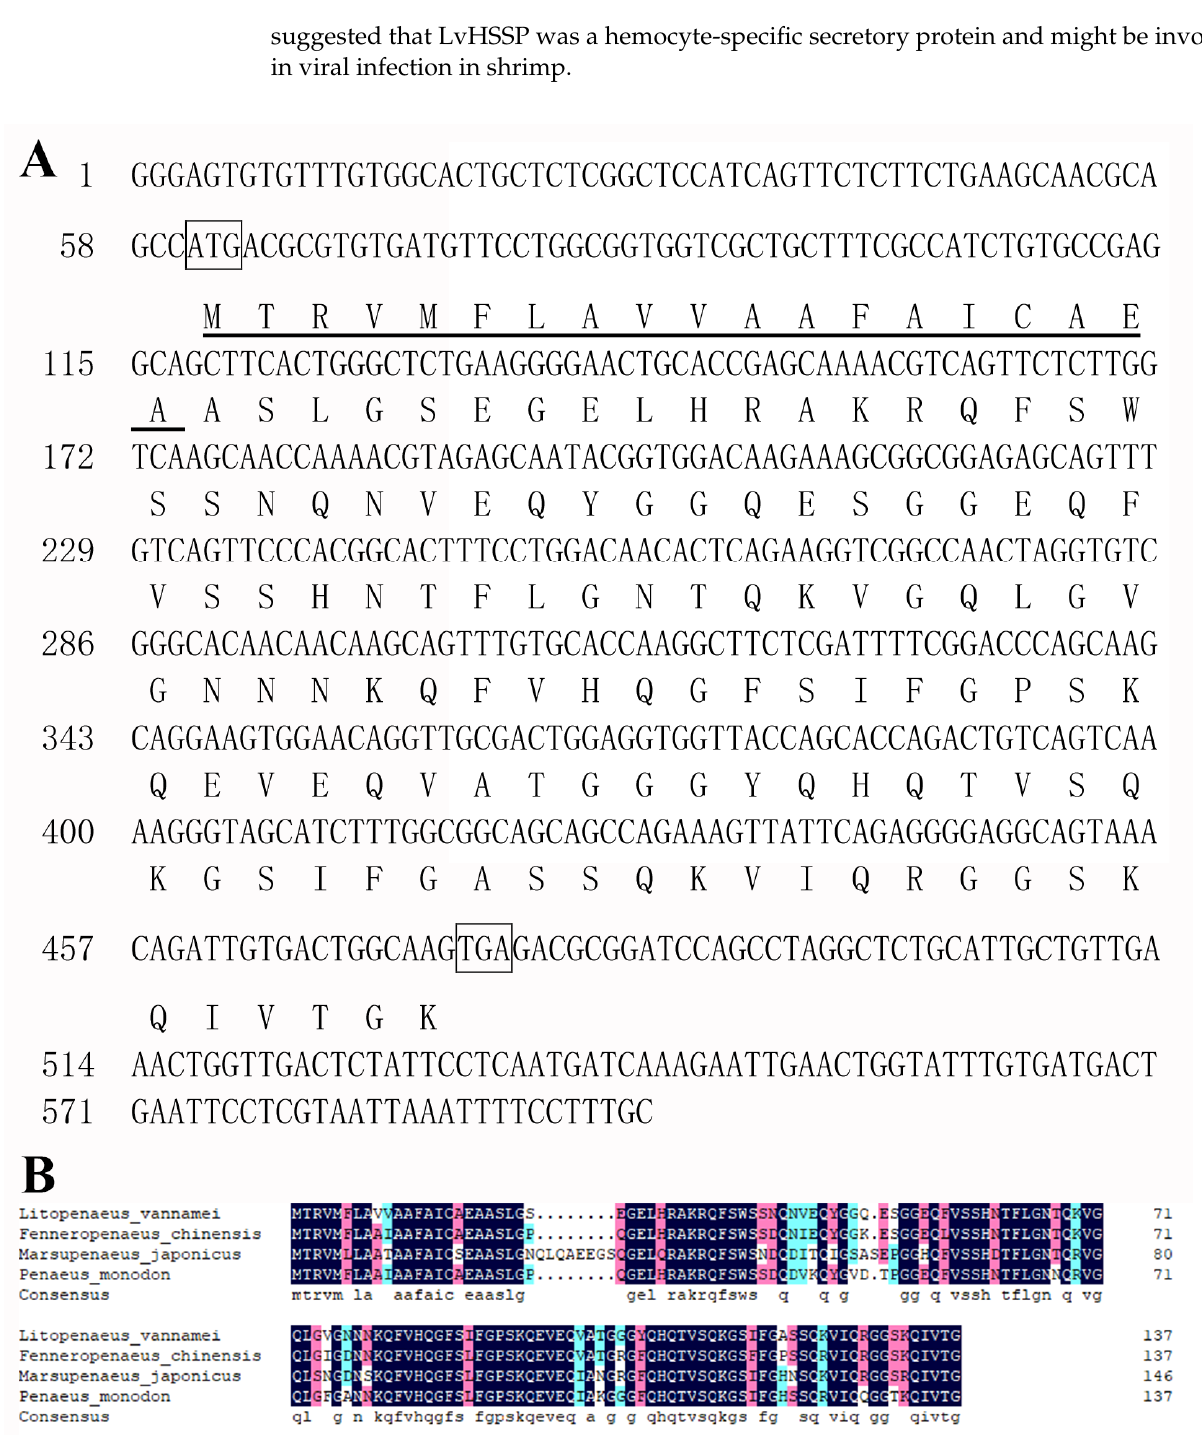
Figure 1. Sequence of LvHSSP. ( A ) Diagram of structure of LvHSSP transcript. ( B ) Alignment of amino acid sequences of LvHSSP and its homologs in other three species of shrimp. GenBank accession numbers of sequences from L. vannamei , F. chinensis , M. japonicus , and Penaeus monodon , were XM_027350838, XM_047642709, LC349927, and XM_037932926,